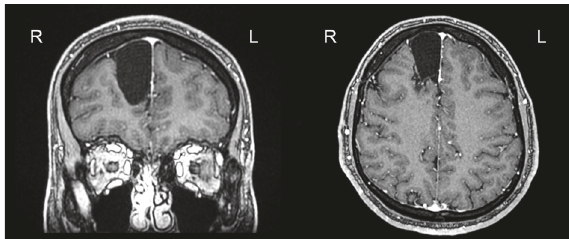
Figure 3: Three-dimensional fast spoiled gradient-echo (3D FSPGR) postcontrast axial and coronal images, showing no defini- tive enhancement of the right frontal